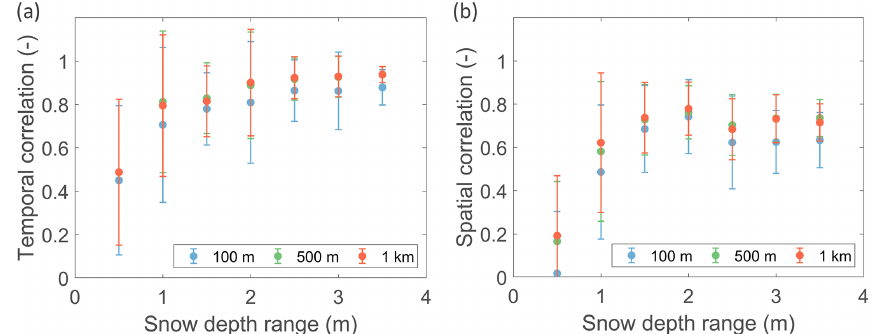
Figure 12. The (a) temporal and (b) spatial correlation between 100m, 500m, and 1km S1 retrievals and in situ measurements for August through April 2017–2018 and 2018–2019. Zero snow depths and wet snow detected by S1 are excluded. The metrics are stratified by the snow depth range (or maximum) of the in situ measurements and represent the mean value and standard deviation per 0.5m interval. Note that for the temporal correlation, the mean and standard deviation are calculated from different locations in space, whereas for the spatial correlation, the metrics are calculated from different time